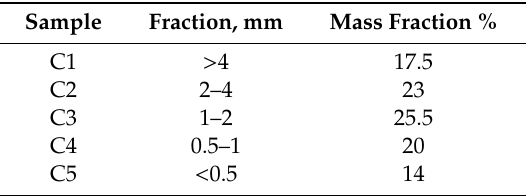
Table 1. Grain-size composition of